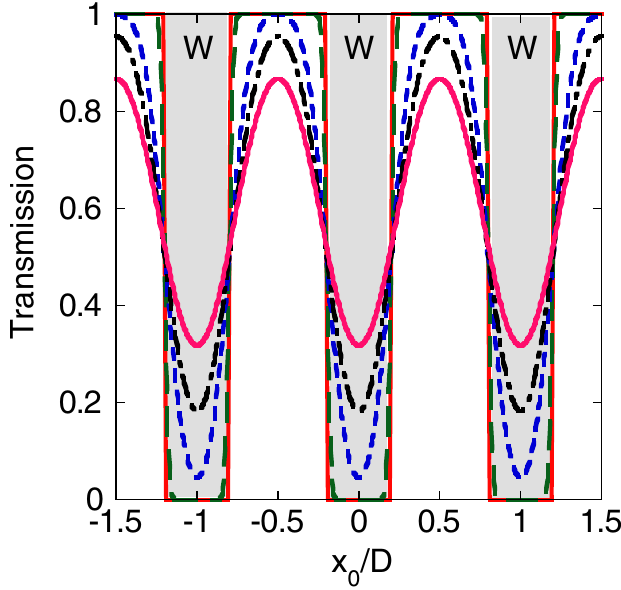
FIG. 7. (Color) Plot of the transmission of a mask [as given by Eq. (10)] with normalized parameters d=D (cid:1) 0 : 4 as a function of the position (corresponding to energy in a dispersive region) of the beam for various ratios of betatron transverse size (cid:6) (cid:4) to mask wire diameter (cid:6) (cid:4) = ð d= 2 Þ ¼ 0 : 01 (red line). 0.1 (green line), 0.5 (blue line), 0.75 (black line, similar to parameters of Ref. [20]), and 1.0 (pink line). The wires are indicated by shaded regions and the letter